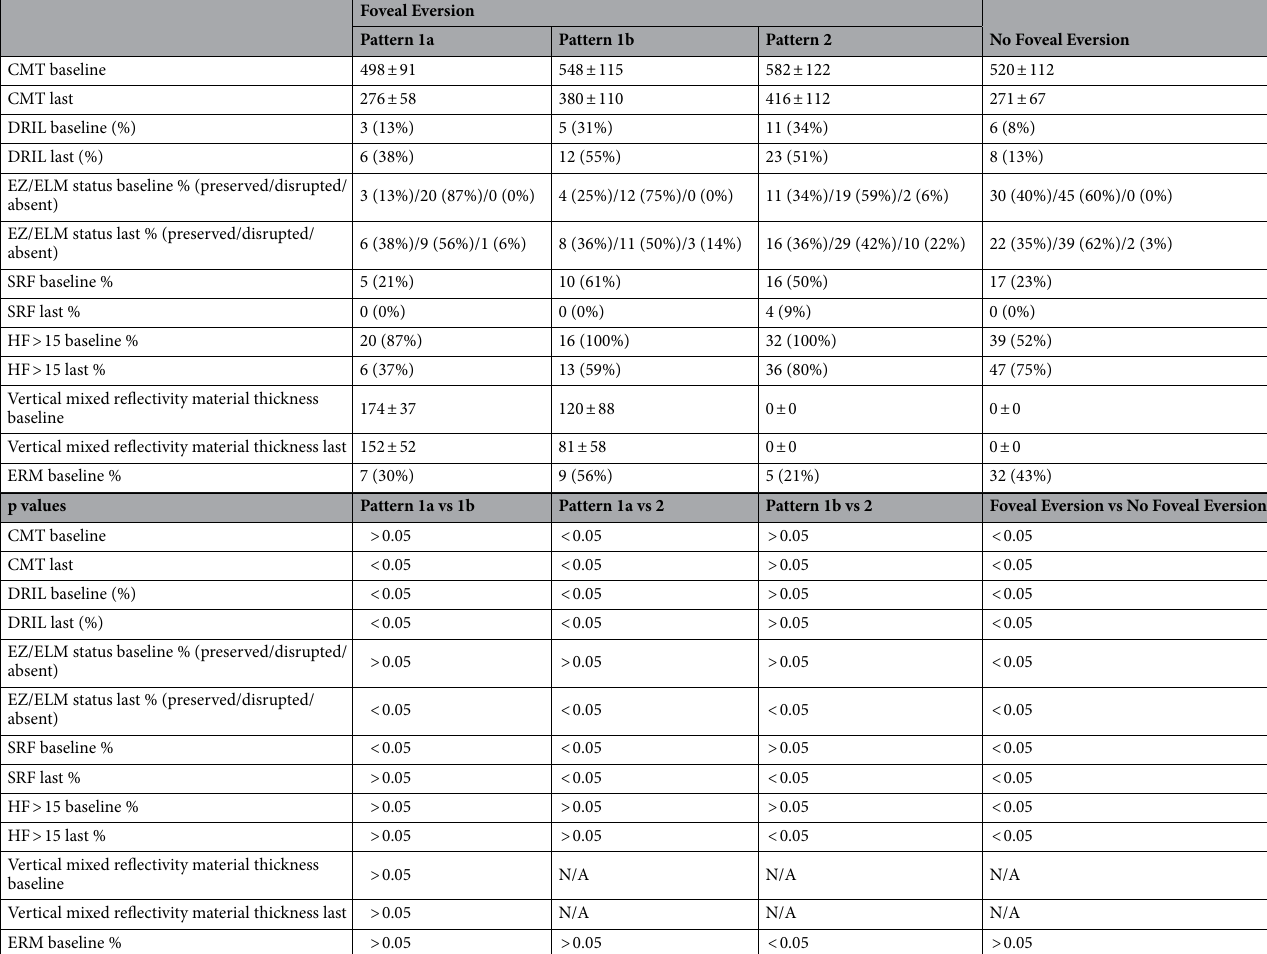
Table 3. Foveal eversion sub-analysis in DME eyes and imaging parameters. DME eyes are divided accordingly with the presence and type of foveal eversion, independently from the treatments. DME